Question: State the chart type depicted above.
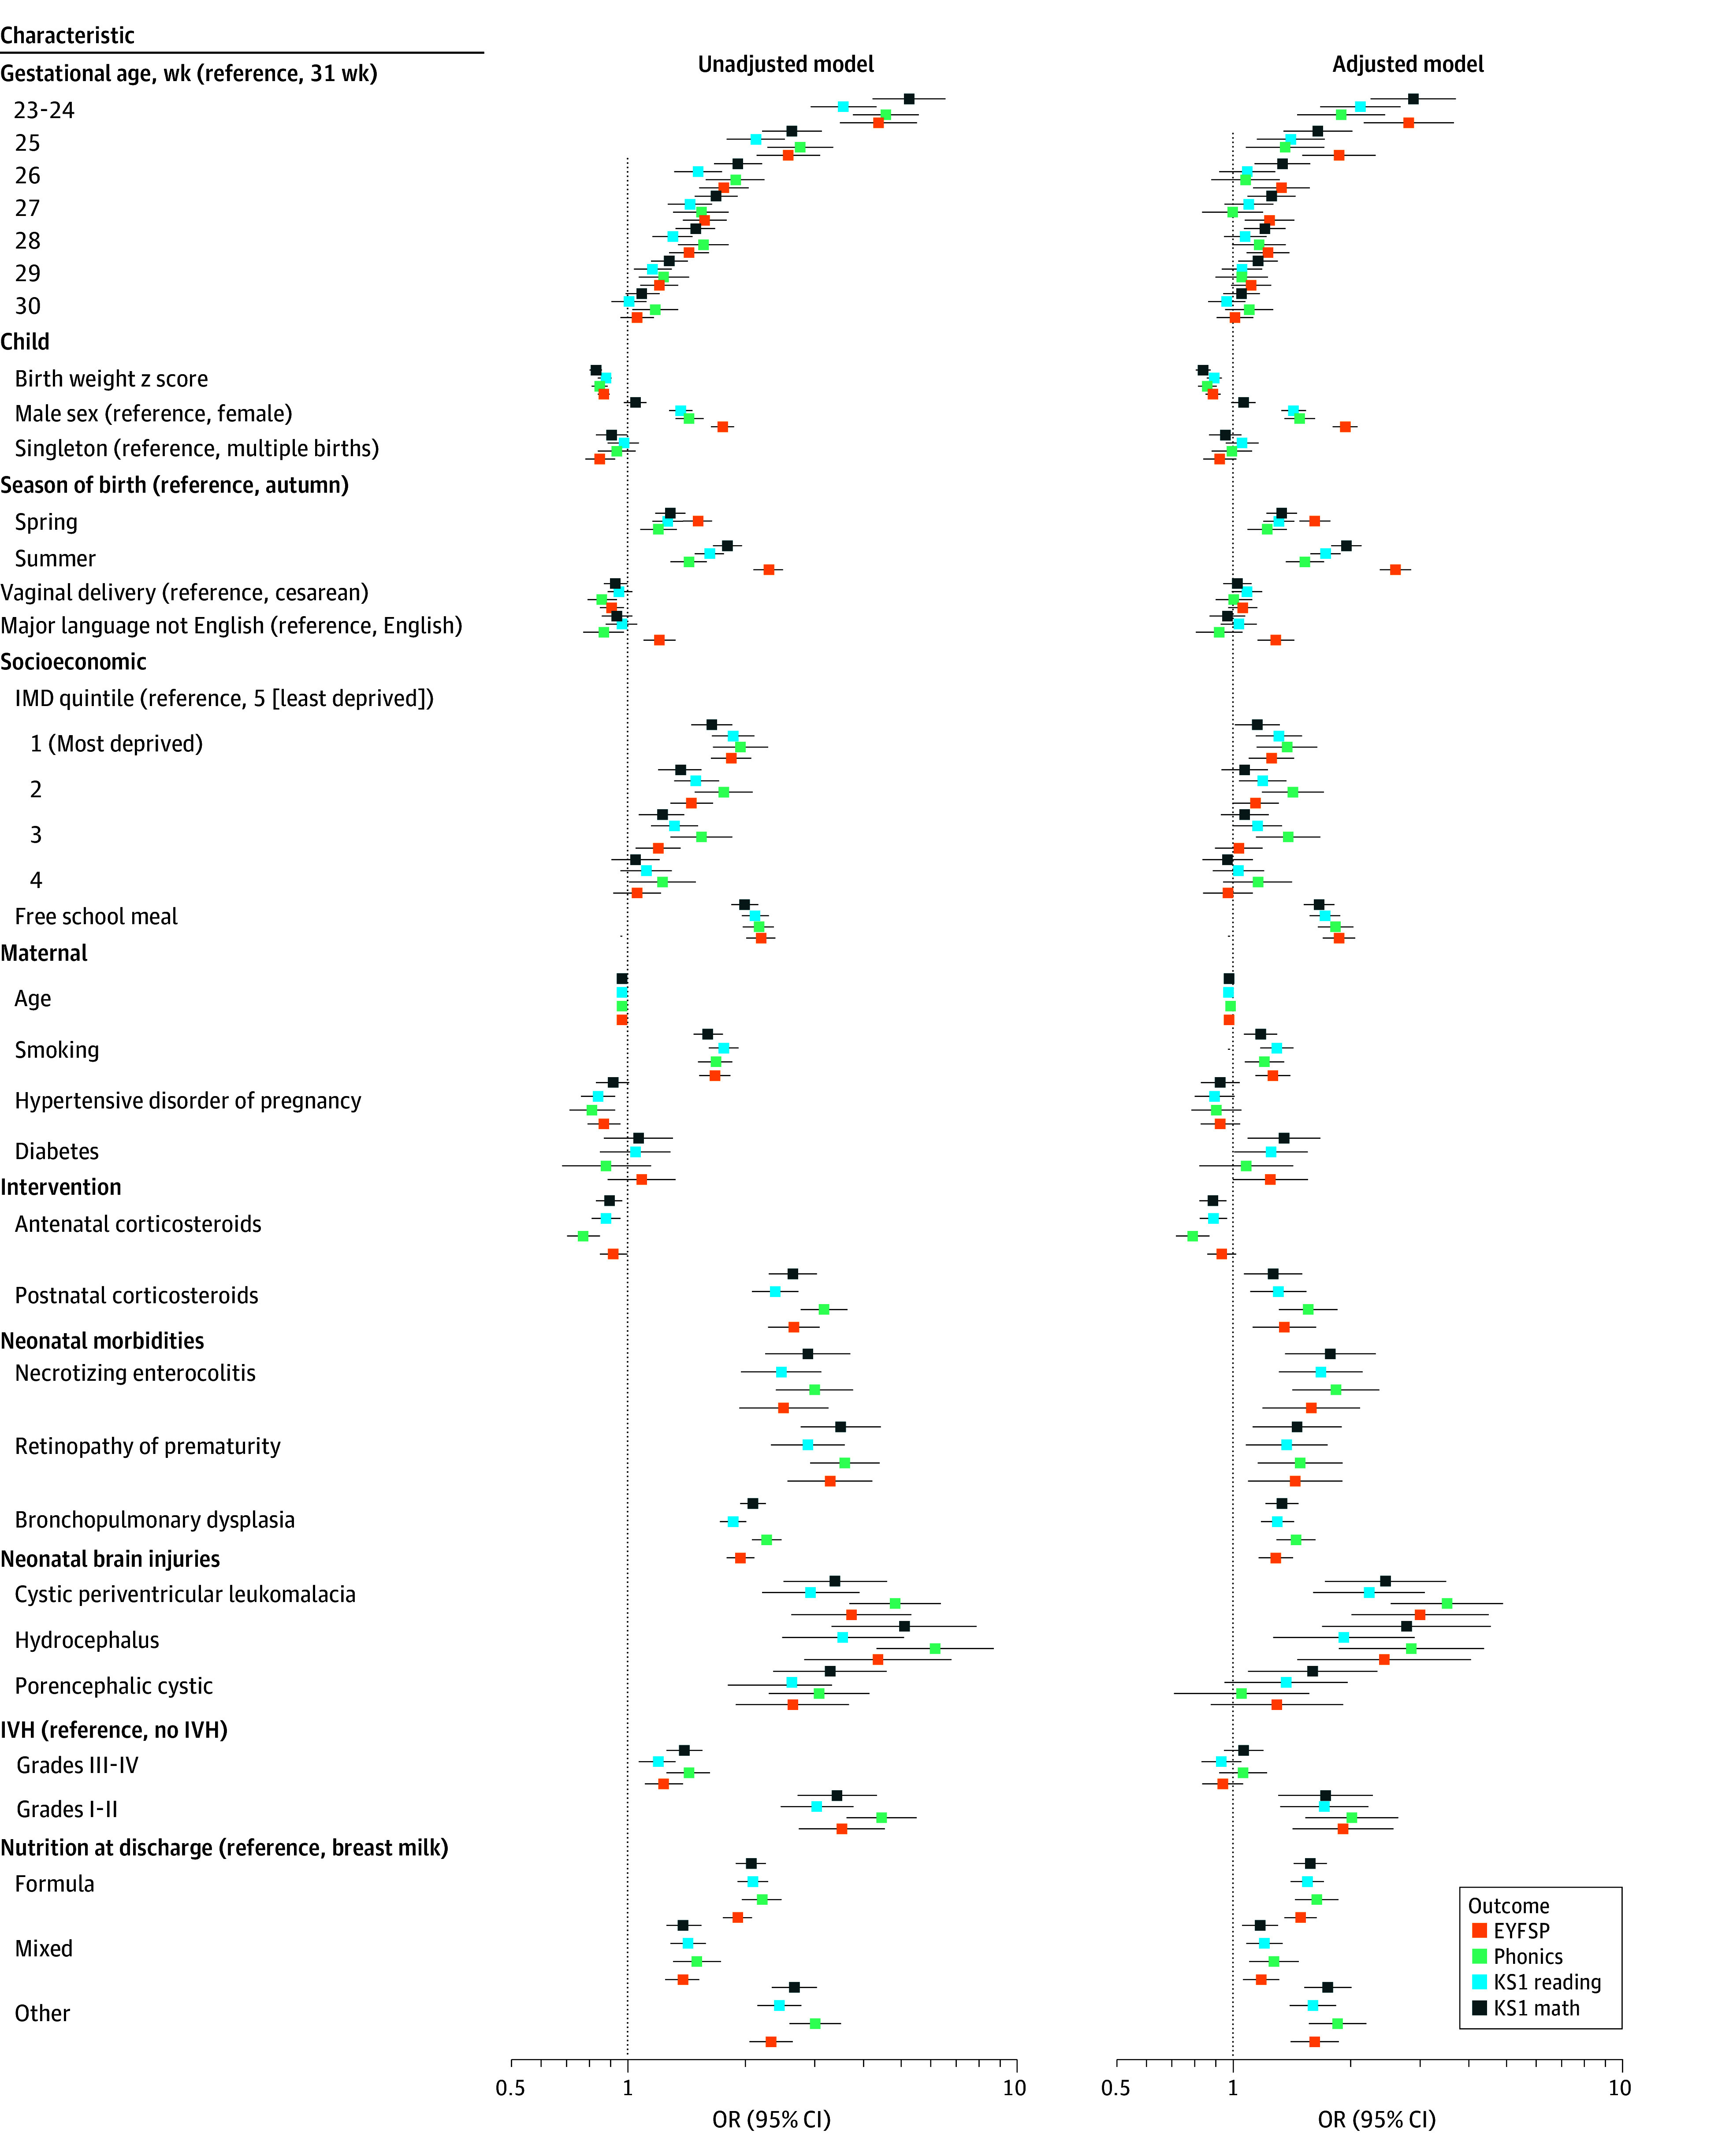
Answer: forest